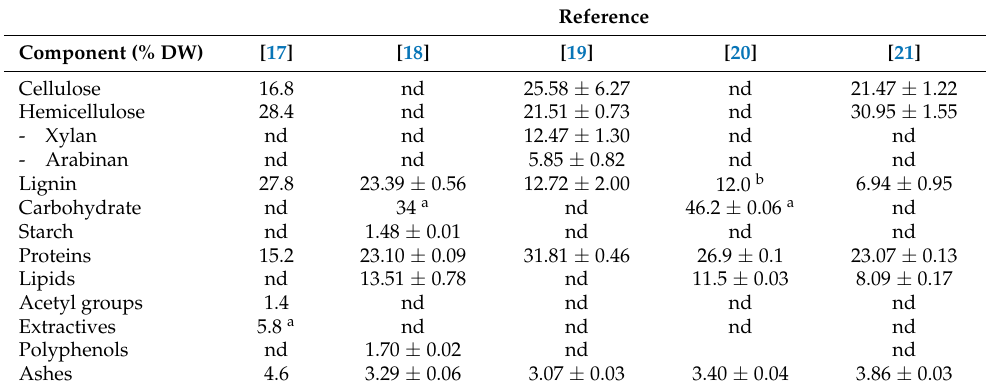
Table 1. BSG chemical composition based on different